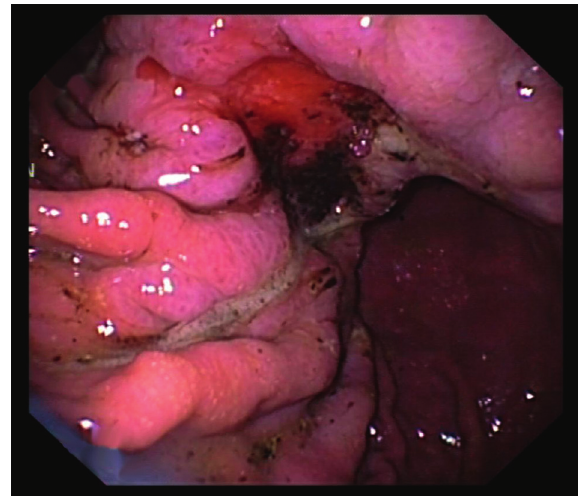
Figure 5: The endoscopic view of hyperplastic lesion in the pyloric canal of the dog.